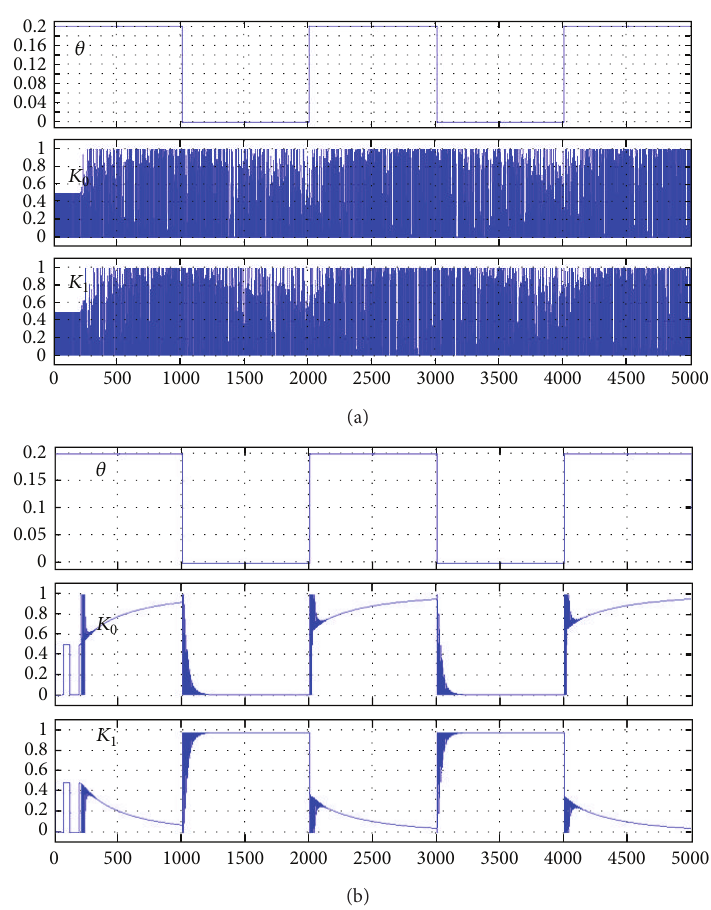
Figure 5: Time diagrams for alternating fault and confidence coefficients of technical states of the control system for (a) independent and (b) interacting